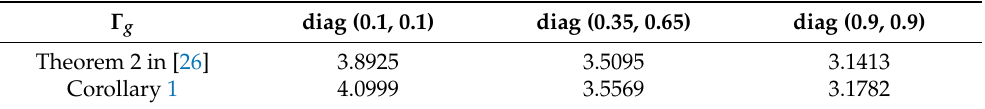
Table 2. Optimal performance β for different Γ g and n ˜ x =